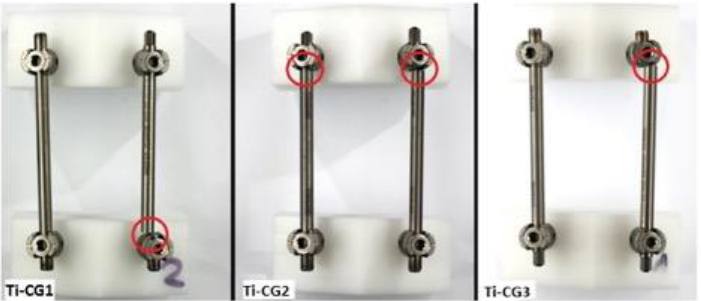
Figure 3. Sites of rod fracture of titanium control group (Ti-CG) post biomechanical testing and fatigue fractures of the rods at the rod-screw junction.